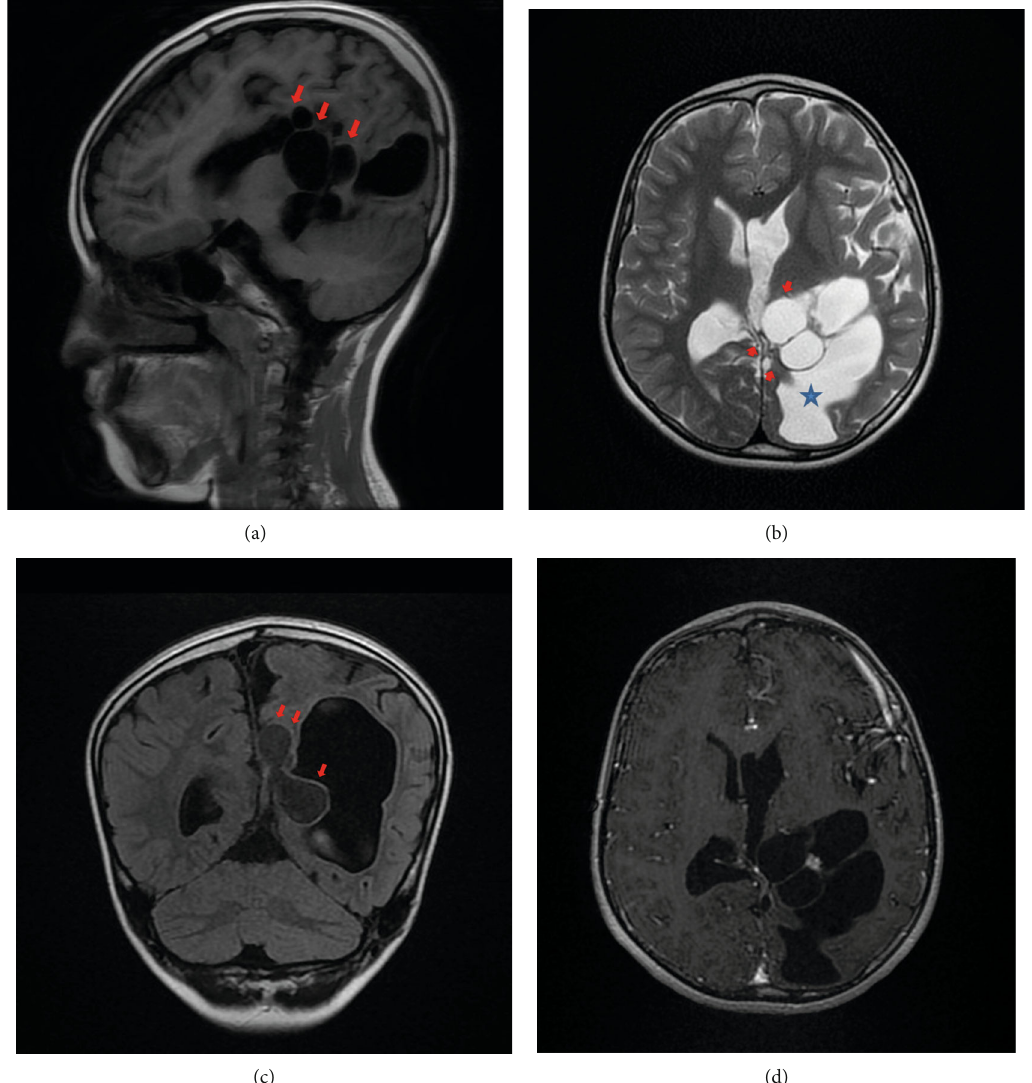
Figure 1: (a) Sagittal slice of T1-weighted image showing the cyst in low signal (arrows). (b) Axial slice of T2-weighted image showing high- signal cyst (arrows) compressing the interventricular foramen responsible for a ventriculomegaly (star). (c) Coronal slice of T2- fl air image showing a discreet high signal of the cyst (arrows) compared to the CSF. (d) Axial slice T1-weighted image after gadolinium injection showing the absence of enhancement of the cyst